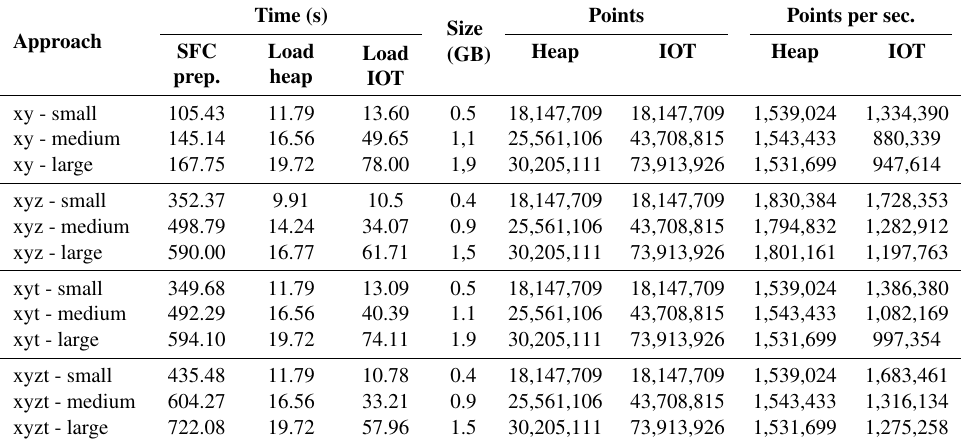
Table 4: The incremental loading times for the two integrations of space and time and the two treatments of z. that the code that we use so far is non-optimised Python